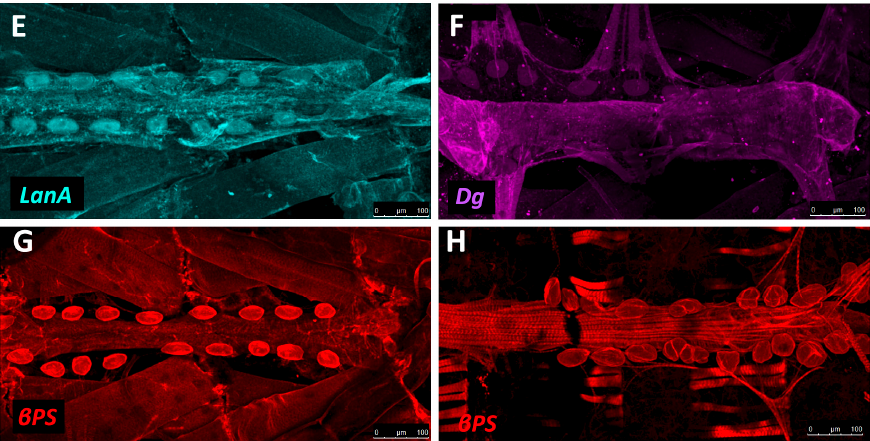
Figure 4. Localisation of ECM proteins and receptors in the larval Drosophila heart. ( A ) Cross-sectional impression of a third instar larval dorsal vessel with flanking PCs. The transmembrane receptors β PS-Integrin and Dg are present along the luminal domain and at the abluminal surfaces of the heart tube. LanA is ubiquitous. Vkg localises to the basal lamina and, at lower levels, within the heart lumen. Prc is absent from the lumen. Dorsal at top; ( B ) The larval dorsal vessel in coronal view (frontal plane), illustrating the aorta and the heart chamber, divided by valve cells. The aorta is comprised of non-contractile cardiomyocytes. The heart chamber is wider and formed from contractile cardiomyocytes and non-contractile ostial cells. Anterior on left. AM: alary muscle; CM: cardiomyocyte; ( C–G ) Distribution of ECM proteins and receptors in late third instar larvae. Anterior on left; ( C ) Vkg is expressed along the basal lamina of cardiac cells, as well as in hemocytes and along the alary muscles and trachea. Actin forms parallel myofibrils that envelop the heart tube, and localises to alary muscles; ( D ) Prc networks localise to the abluminal surface of the heart tube, and envelope the PCs; ( E ) LanA is expressed along the luminal and abluminal cardiac cell surface, along the pericardial cell surface, and within muscle costameres (banded pattern); ( F ) Dg is expressed along the heart tube and pericardial cell surface, and within the costameres. Alary muscle tissue is also labelled; ( G ) β PS-Integrin is expressed along the heart tube and pericardial cell surface. Integrin is expressed along costameres (banded pattern); ( H ) Five-day-old adult stained for β PS-Integrin. Integrin is expressed by new longitudinal muscles ventral to the heart tube, and by PC and costameres.